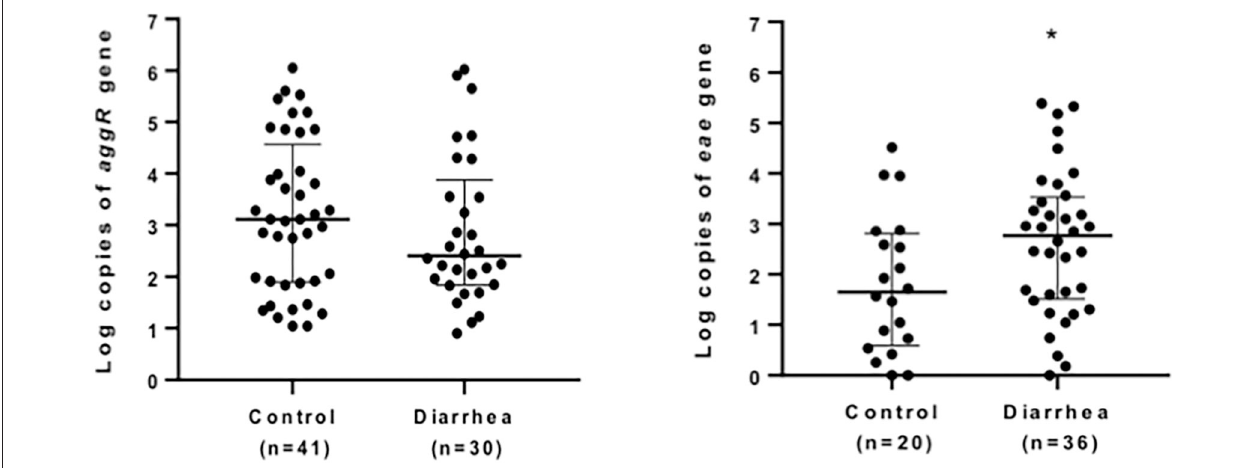
FIGURE 1 | Quantification of eae - and aggR - markers in stool. Positive stool samples for aggR (left) or eae (right) markers from children with (diarrhea group) or without (control) diarrhea were analyzed by quantitative qPCR. Data are presented as median log copy number/mg of stool sample ± IQR. * P < 0.05 (Mann-Whitney U